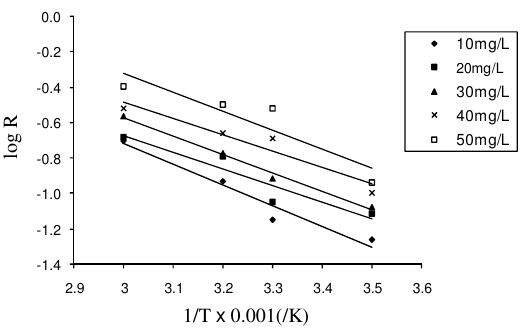
Figure 5. Arrhenius plot for the adsorption of various concentrations of Zn 2+ onto human hair